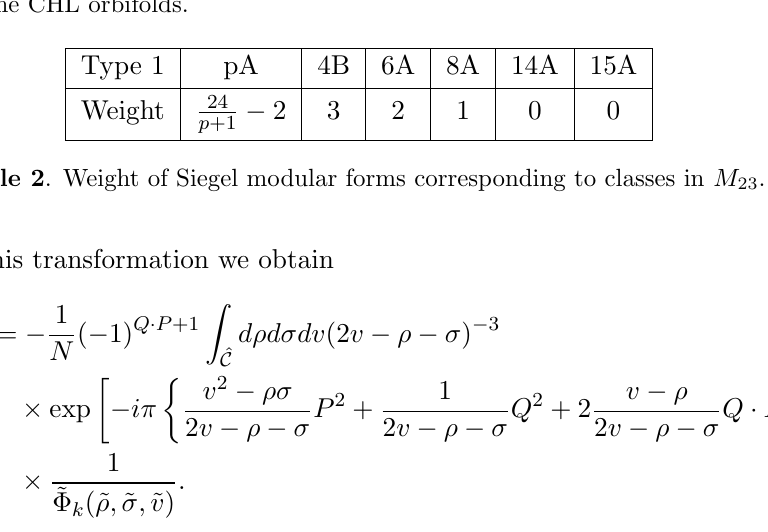
Table 1 . Conjugacy classes of M 24 studied in the paper. We refer to the classes 2A, 3A, 5A, 7A, 4B, 6A, 8A as the CHL orbifolds.